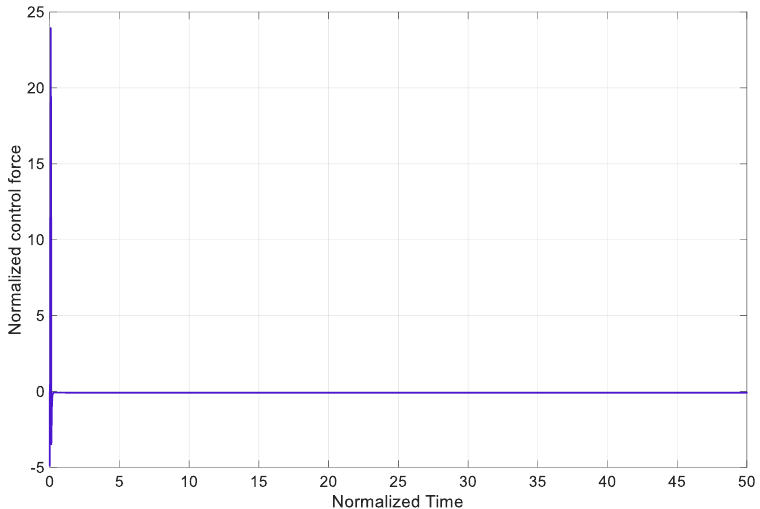
Figure 5. The control input for the CNT with uncertain parameters.